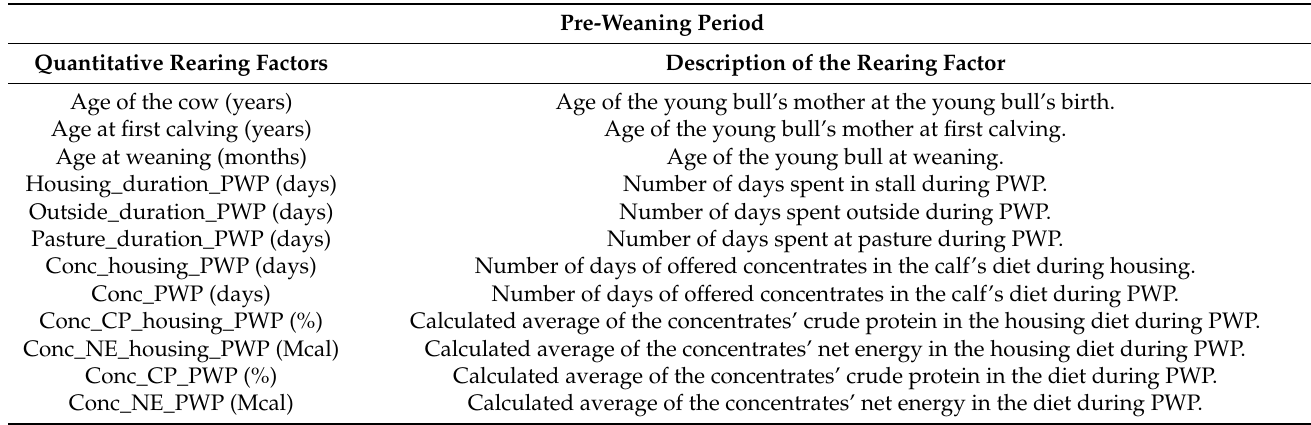
Table 1. Definition of the rearing factors characterizing each key period of the young bull’s life. Pre-Weaning Period Description of the Rearing